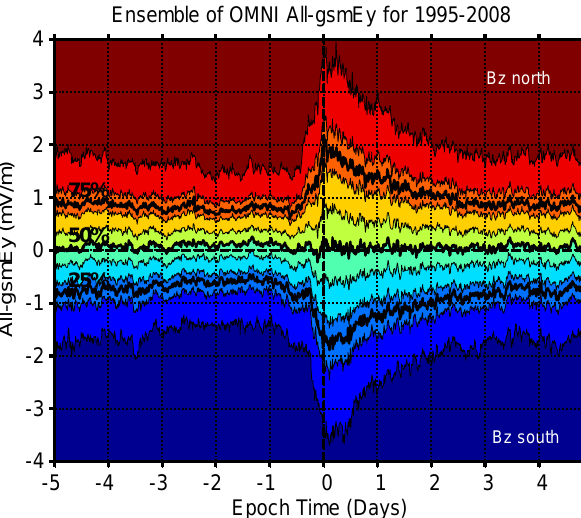
Fig. 4. A dynamic cumulative distribution function (cdf) for the gsm IMF dawn-dusk electric field ( V B z ) for “All” nine years of data measured at the ACE spacecraft. Heavy lines are quartiles of the distribution and thin lines are deciles. The vertical dashed line at zero epoch time is the time a stream interface at the center of a corotating interaction region (CIR) passed the spacecraft. We have reversed the sign of E y to correspond to B z